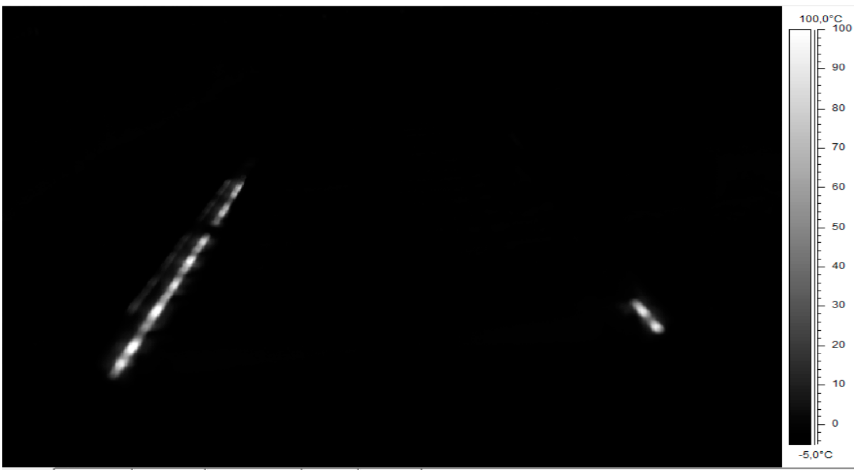
Figure 10. Thermogram IR_0145—grey colour palette (source: authors).